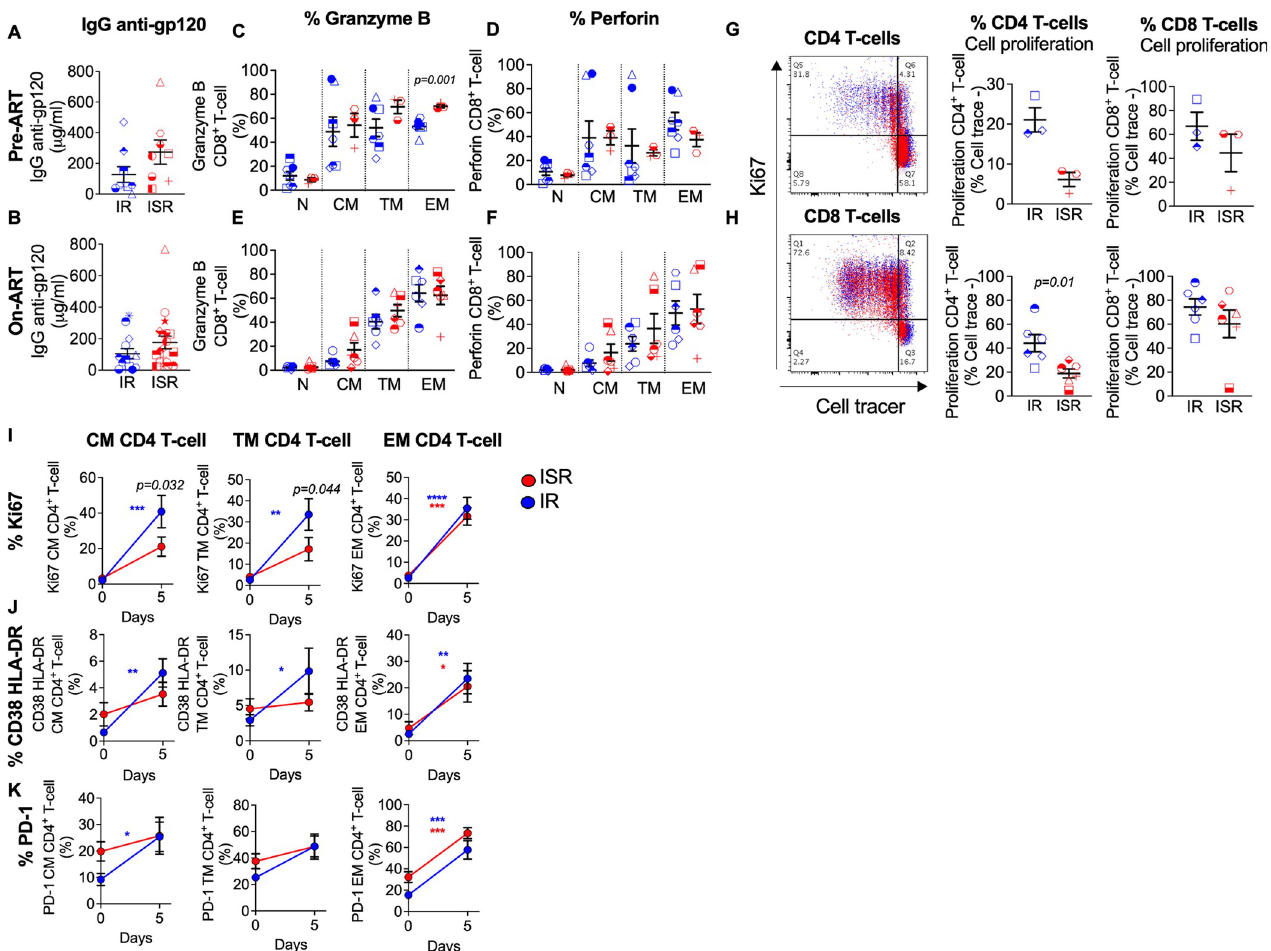
Fig 5. Lower response to homeostatic cytokines characterize CD4 T-cells of ISRs. Plasma IgG antibodies against HIV-gp120 (A) before ART (IR, n = 9; ISR, n = 8), (B) and after ART initiation (IR, n = 13; ISR, n = 19) in ISR and IR individuals. Expression of cytolytic markers, (C, E) granzyme B and (D, F) perforin on CD8 T-cell subsets of PBMCs before (IR, n = 7; ISR, n = 3), and after (IR, n = 6; ISR, n = 6) ART initiation. Cell proliferation capacity (cell trace -) of CD4 and CD8 T-cells at day 7 after IL-15+IL-7 stimulation of (G) pre- (IR, n = 3; ISR, n = 3), and (H) on-ART (IR, n = 6; ISR, n = 6) samples. (I) Expression of Ki67, (J) CD38 HLA-DR, and (K) PD-1 in sorted CD4 T-cell subsets (CM, TM, and EM T-cells) at baseline and day 5 after IL-15+IL-7 stimulation from on-ART ISR (n = 6) and IR (n = 6) individuals. Blue indicates IR, red indicates ISR. CD4 T-cell subsets included na ï ve (N), central memory (CM), transitional memory (TM), and effector memory (EM) cells. Averaged data are presented as the mean ± SEM. Mann Whitney u-test was used in (A-H). Two-way ANOVA with Sidak’s multiple comparisons test was used in (I, J, and K). Asterisks indicate comparisons between baseline and day 5 time point, and p-values indicate comparisons within IR and ISR at the same time point. � P < 0.05, �� p < 0.01, ��� p < 0.001, ���� p � 0.0001.